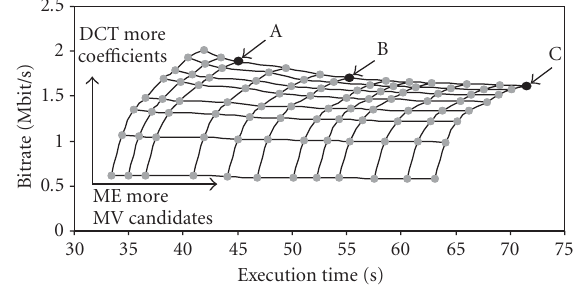
Figure 20: Example of ME scalability for the complete encoder when using a (12,4)-GOP (“IBBBP” structure) for coding.